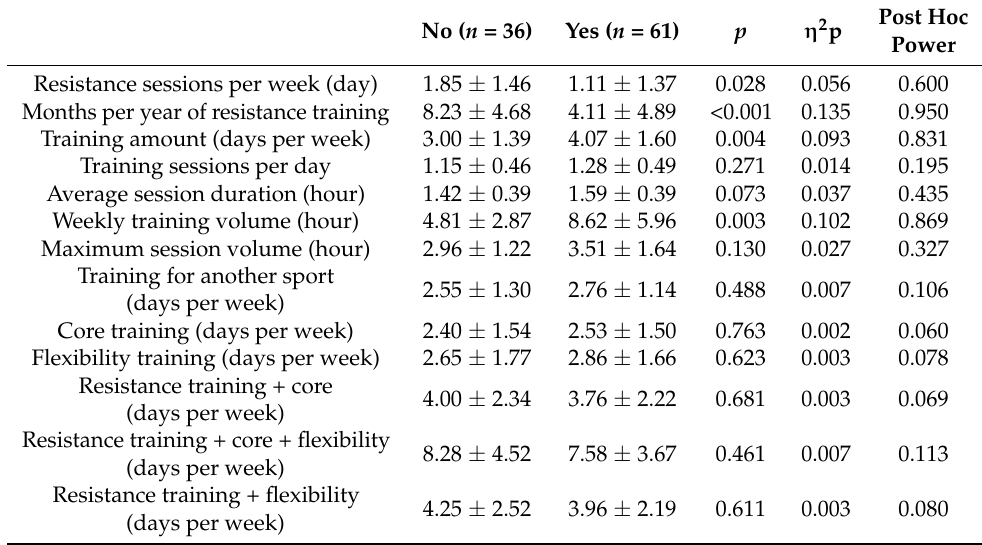
Table 3. Training characteristics of participants based on state of injury.